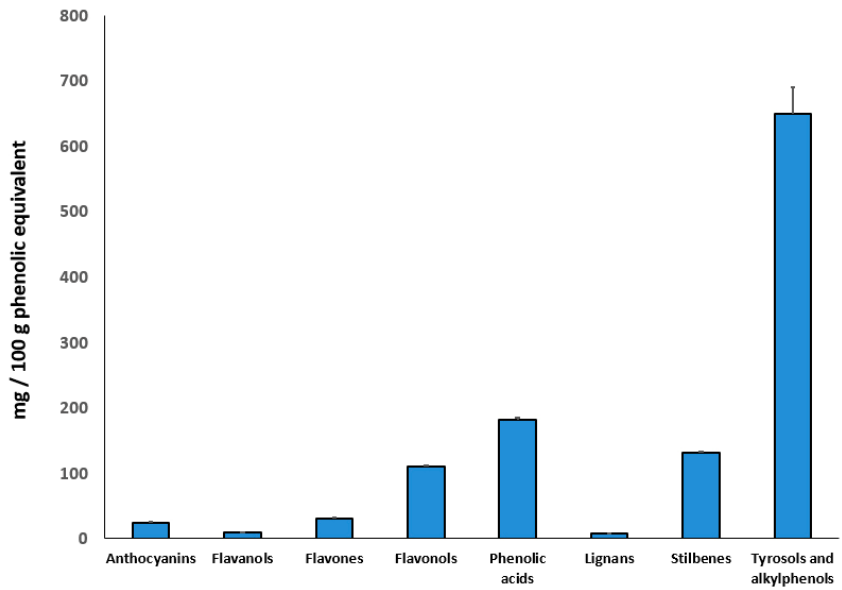
Figure 4. Abundance of phenolic compounds (mg 100 g − 1 ) in the duckweed. Compounds have been screened by untargeted metabolomics, and cumulative abundance per each class quantified against a representative compound per each class.